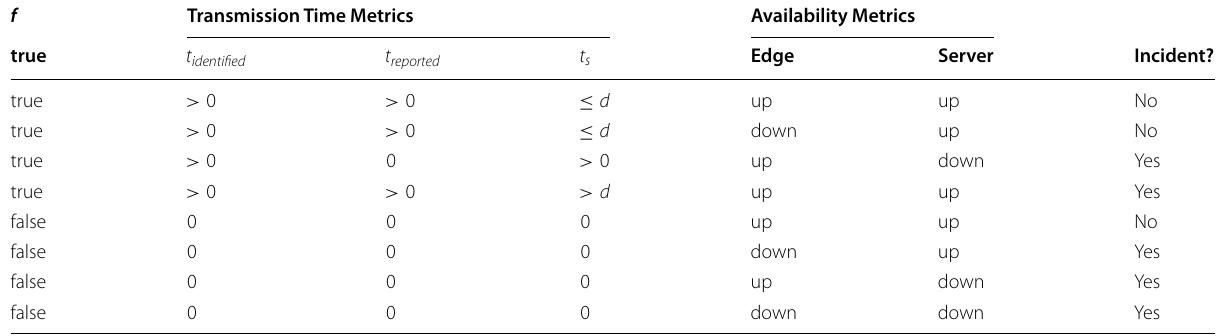
Table 1 Classification and summary of metrics covered by Algorithm 1